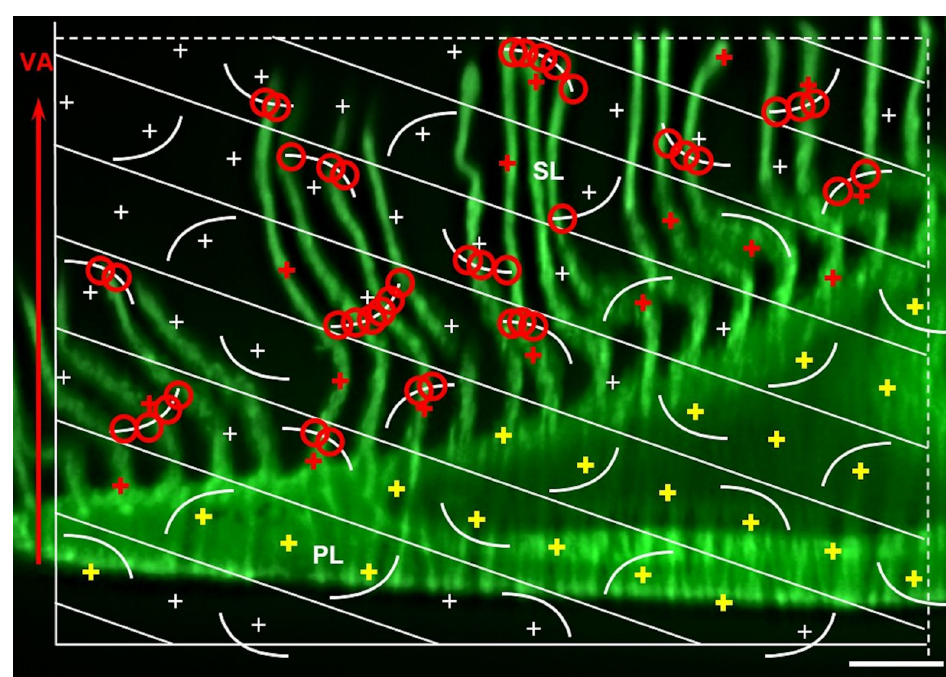
Fig 20. Estimation of S V(SL/GF) in VUR autofluorescence images acquired by LSFM of optically cleared GF samples. Here, a SUR sampled field of view from a (virtual) optical VUR section is shown, generated as described in Section 16.2 and Fig 18 . The orientation of the vertical axis ( VA , red arrow) and the size ruler are indicated. The VUR images are overlaid with a stereological test system combining cycloids and test points. The short side of the rectangular frame of the system is aligned parallel to the orientation of the VA. All points hitting GF section profiles (P (GF) , including PL section profiles (P (PL) , yellow crosses) and SL section profiles (P (SL) , red crosses)) are counted, as well as all intersections of cycloid arches with the epithelial surface of SL section profiles (I (SL) , encircled in red). [In the present example, a test system combining 35 cycloid arches and 70 points is used, refer to Fig 13 . 21 P (PL) and 16 P (SL) ( i . e ., 37 P (GF) ), and 41 I (SL) are counted]. S V(SL/GF) is calculated from the sum of intersections ( ∑ I (SL) ) and points ( ∑ P (GF) ), counted in all examined test fields of all sections of all samples per case, using Eq 6 . LSFM-autofluorescence image acquired at 520/40 nm (ex) and 585/40 nm (em). Bar = 100 μ m.